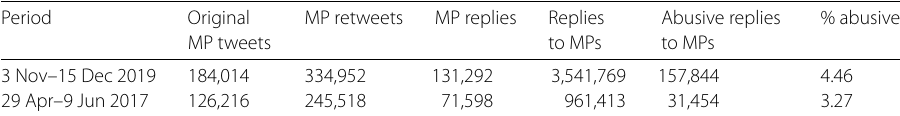
Table 1 Sample statistics for the individuals studied. All candidates for the UK 2019 parliamentary election are included, where we were able to obtain a Twitter account for them Party Female Male Non-binary Total Not male Labour Party 310 275 1 586 53.07 Conservative Party 162 367 0 529 30.62 Liberal Democrats 168 352 1 521 32.44 Green Party 150 211 2 363 41.87 The Brexit Party 43 153 0 196 21.94 Independent 23 86 0 109 21.10 Scottish National Party 20 39 0 59 33.9 Plaid Cymru 22 0 30 50 138 0 188 26.60 Total 934 1643 4 2581 36.38